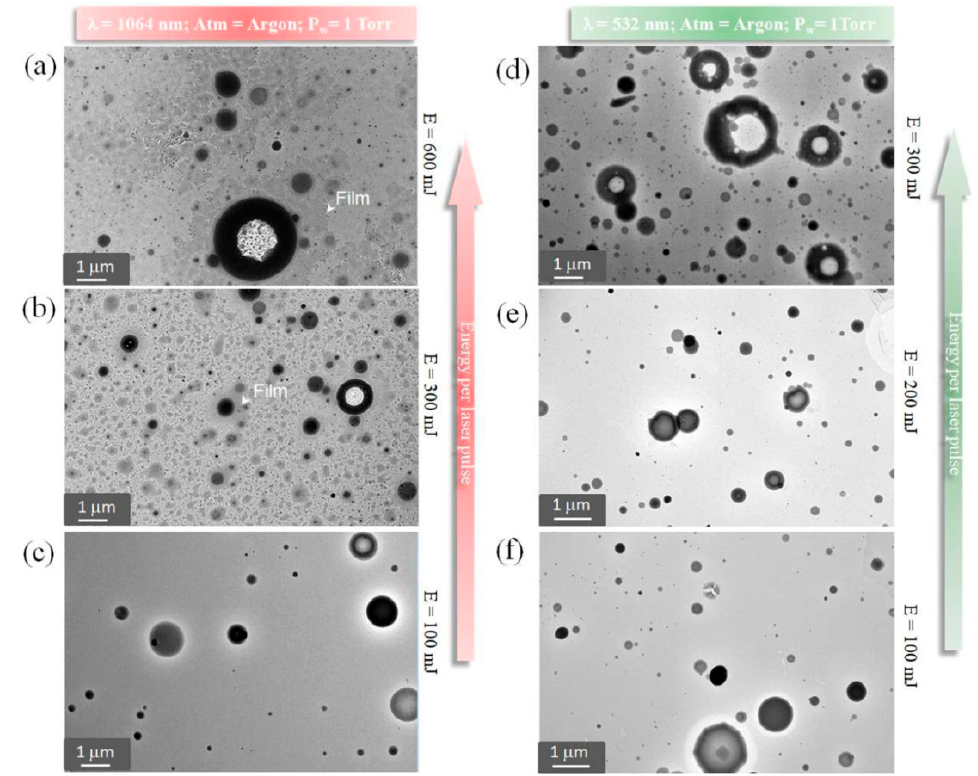
Figure 2. The effect of laser wavelength and fluence on the mechanism of HA ablation and film growth. ( a – c ) TEM images of HA films deposited at different fluencies by a ns laser source operating at 1064 nm; ( d – f ) TEM images of HA films deposited at different fluencies by a ns laser source operating at 532 nm. Reproduced with permission from [68], copyright from 2021 Elsevier.